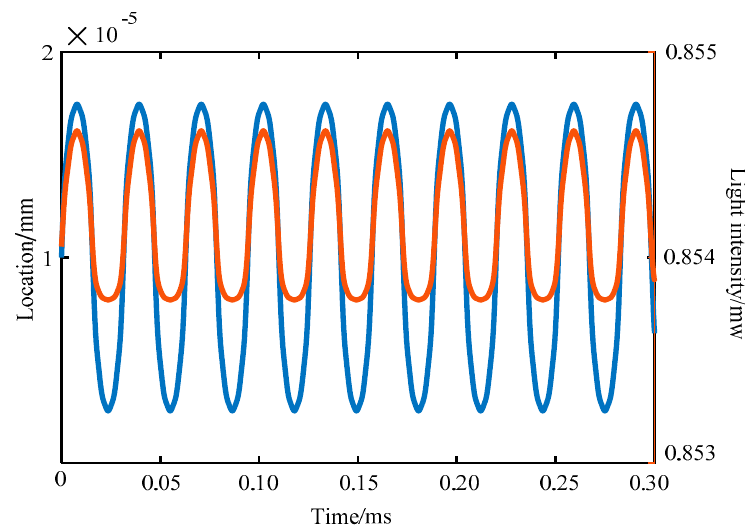
Figure 3. Vibration signal position and interferometer output light intensity variation with time.